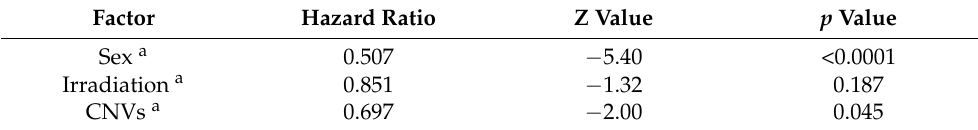
Table 7. Effects of sex, irradiation, and CNVs on life span of F1